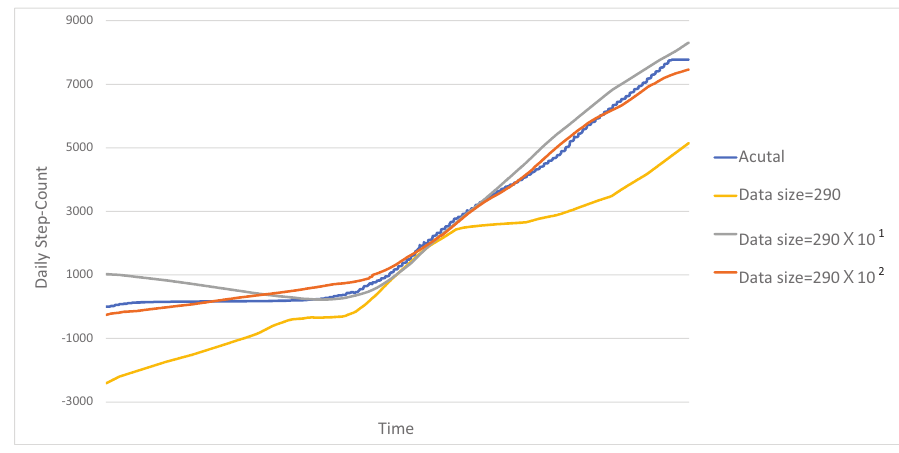
Figure 4. Actual vs estimated aggregate health data sequences for various data sizes ( (cid:101) = 1.0).